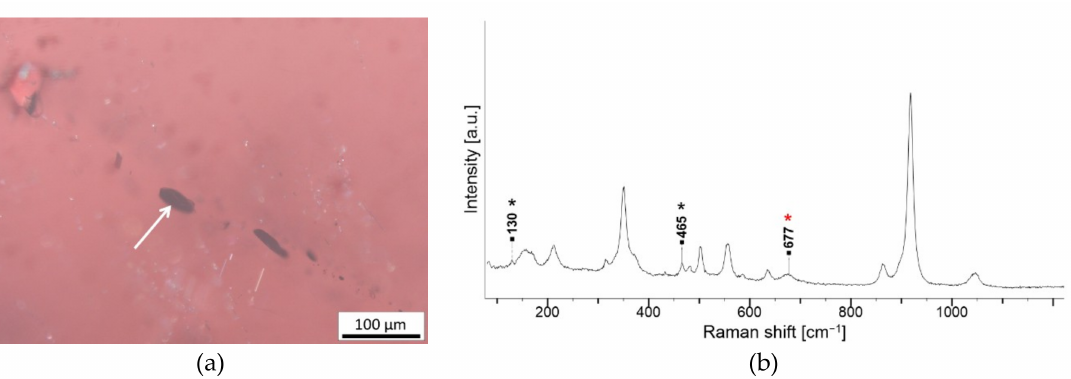
Figure 10. Inclusions in garnet G1 of fibula NA247 and garnet G2 of fibula NA401. ( a ) A group of elongated inclusions of Fe oxides (i.e., ilmenite) in NA401 G2. Reflected light, parallel polars; ( b ) Raman spectrum of quartz with bands at 130, 465 cm − 1 (black asterisk) and ilmenite at ~680 cm − 1 (red asterisk) in almandine garnet.